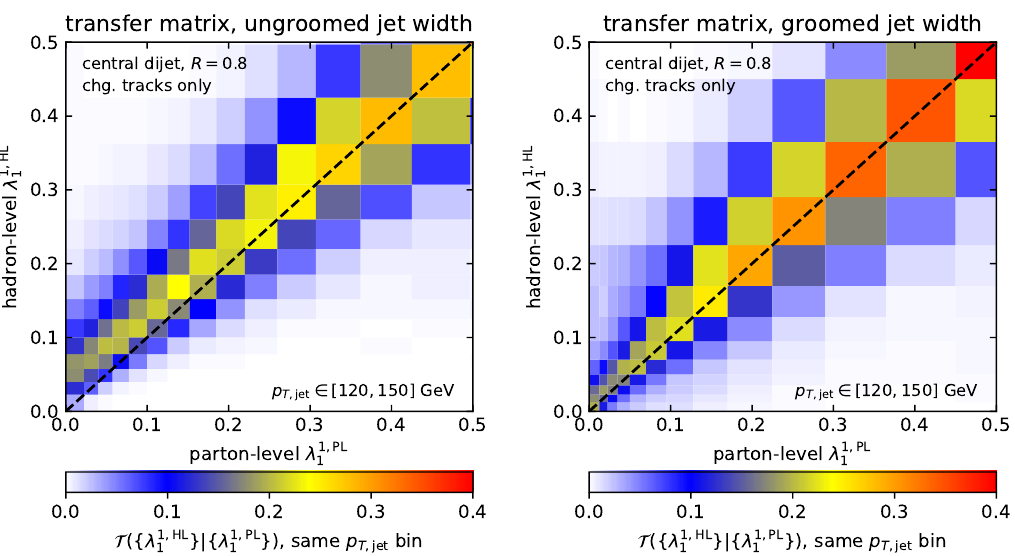
Figure 4. Transfer matrix T ( { λ 1 , HL }|{ λ 1 , PL } ) for the jet width, λ 1 , for central dijet events with 1 1 1 R = 0 . 8 and p T, jet ∈ [120 , 150] GeV. The angularities at hadron level are measured on charged particles only. For simplicity of the presentation, we here assumed no p T, jet migration. The left (right) plot corresponds to ungroomed (groomed) jet